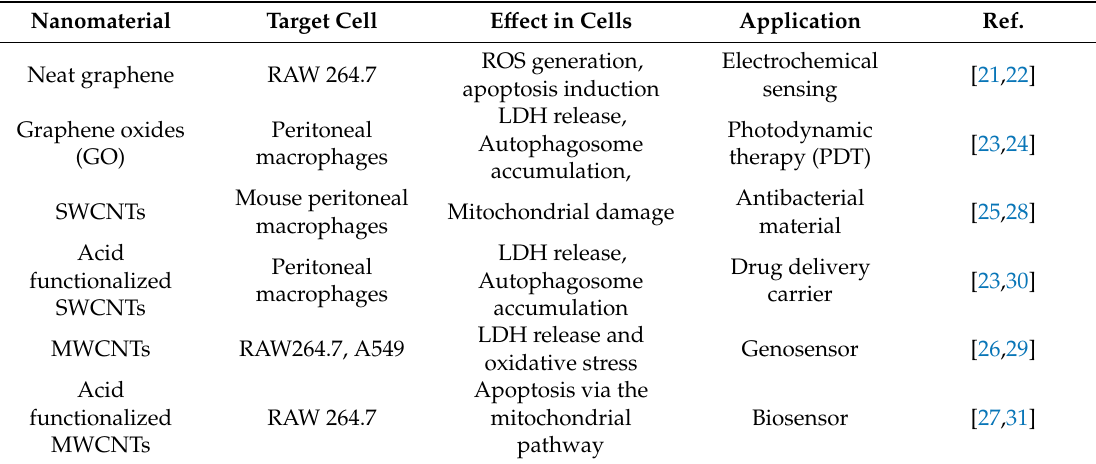
Table 1. Toxicity and application of carbon